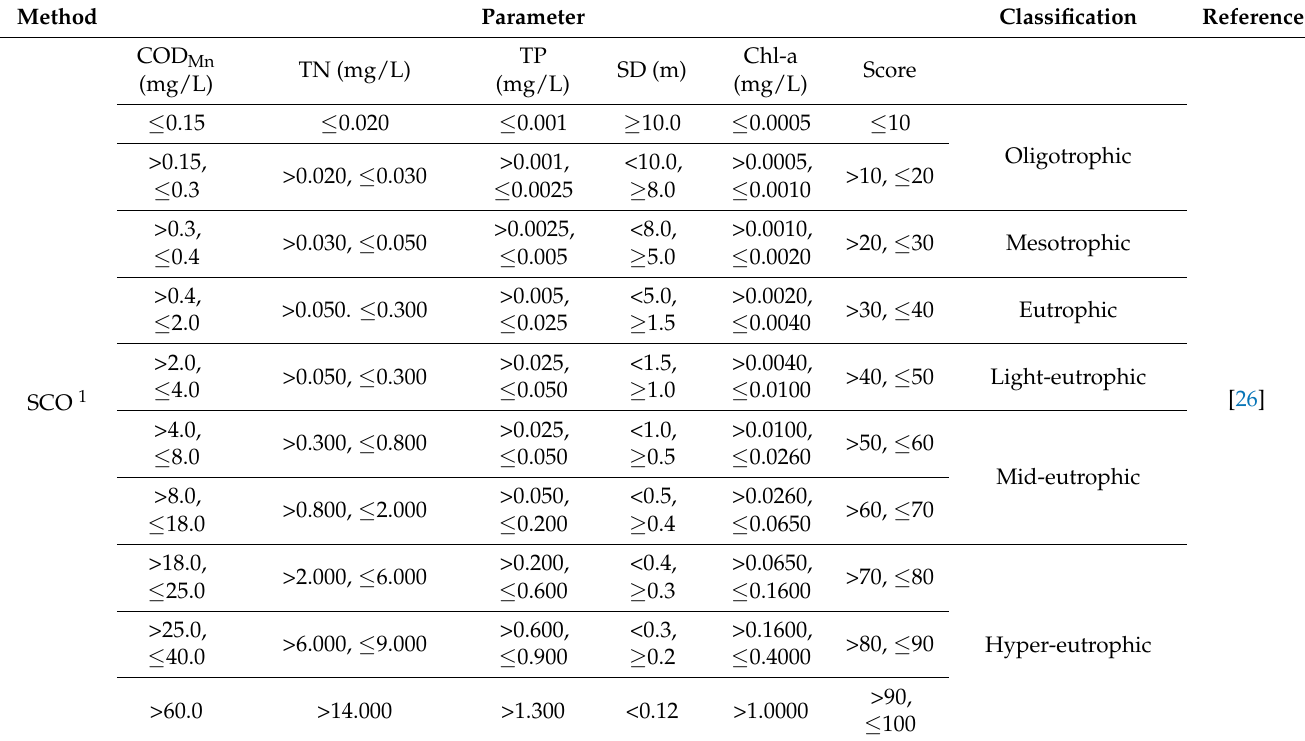
Table 2. Water eutrophication evaluation parameter and